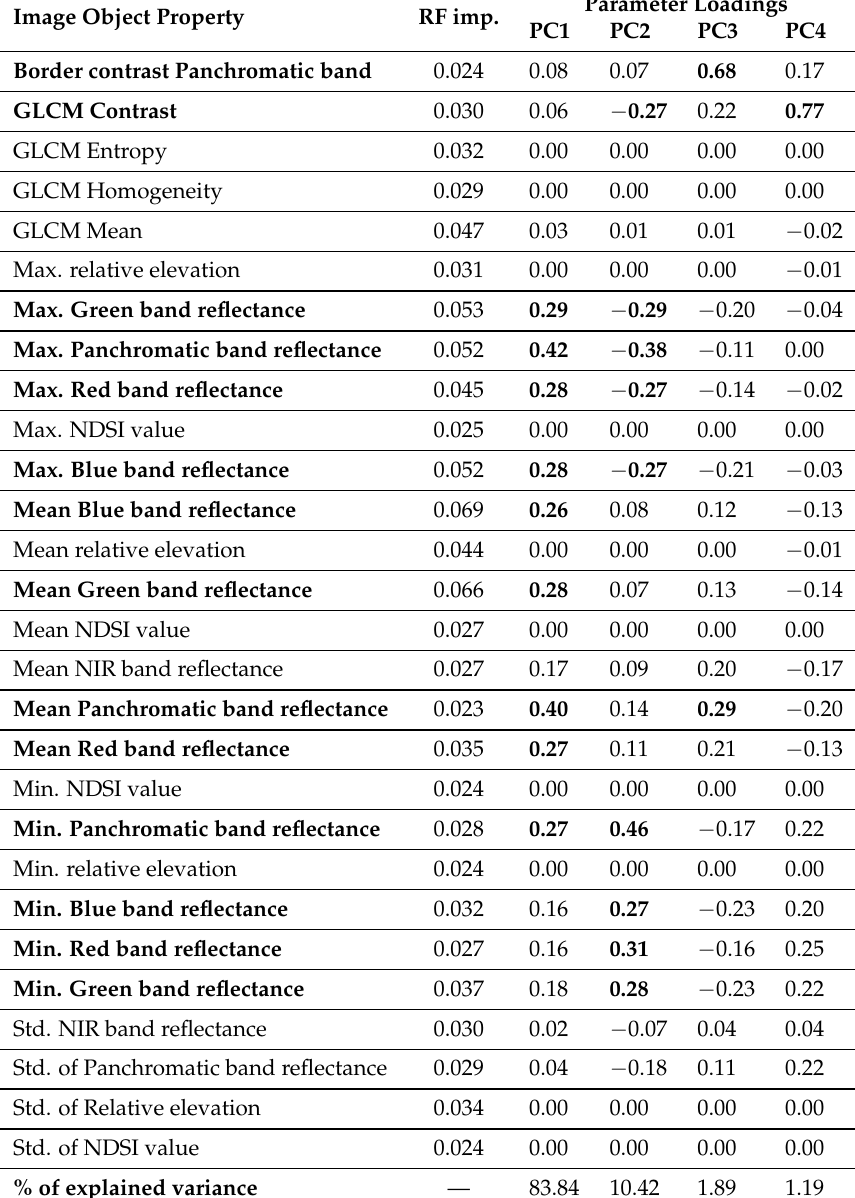
Table 3. List of properties of image objects used as variables during the Random Forest classification and results of PCA analysis of their importance. “RF imp.” stands for “Random Forest Importance”, as returned by eCognition. Columns 3–6 list loadings of properties in the four Principal Components with largest explained variance in the classified objects dataset. Absolute loadings higher than 0.25 and properties carrying them are shown in bold. All minima, maxima, means and standard deviations are computed from pixels within a single